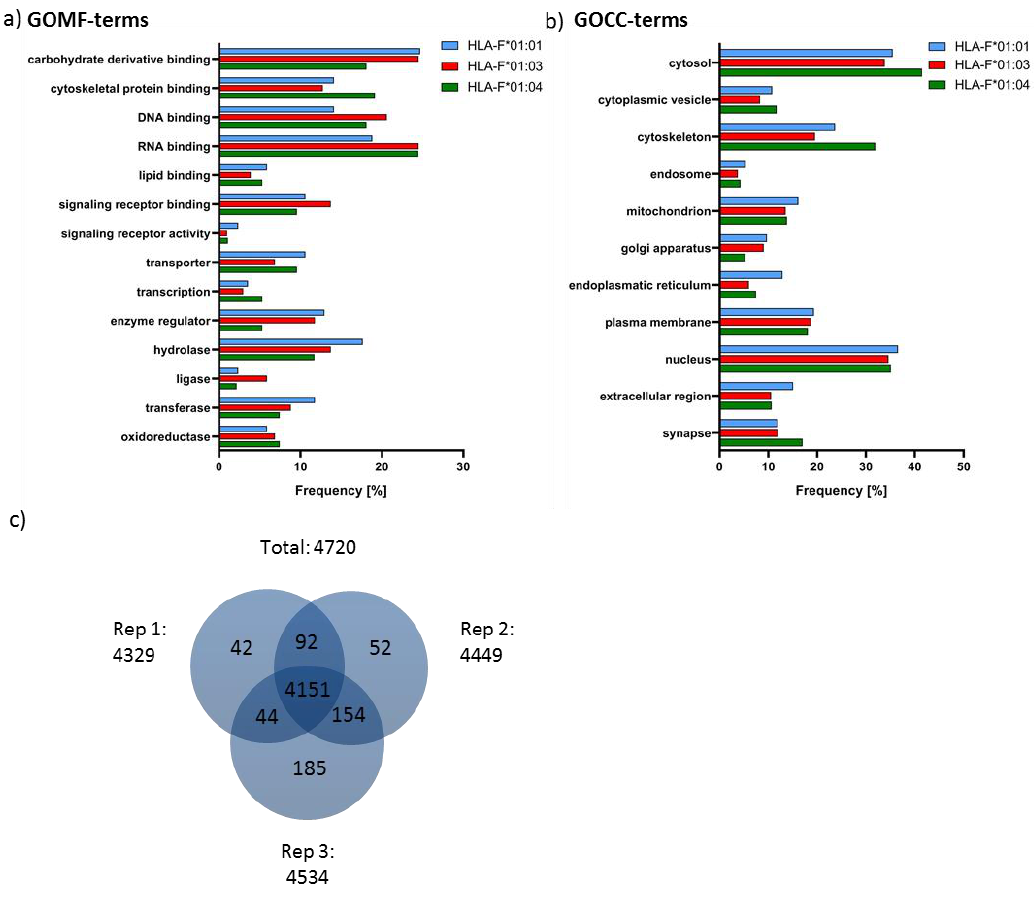
Figure 3. Data analysis of identified HLA-F selected proteins and proteome analysis of K562 cells. ( a ) Gene ontology molecular function (GOMF) analysis of HLA-F presented peptides. Depicted are selected gene ontology GO terms and the involvement of the protein in every category of selected GOMF. ( b ) Gene ontology cellular component (GOCC) analysis of HLA-F presented peptides. Depicted are selected GO terms and the presence of the protein all cellular compartments. ( c ) Venn diagram of identified proteins within three biological replicates. Only proteins that were identified in all replicates were considered for quantification.